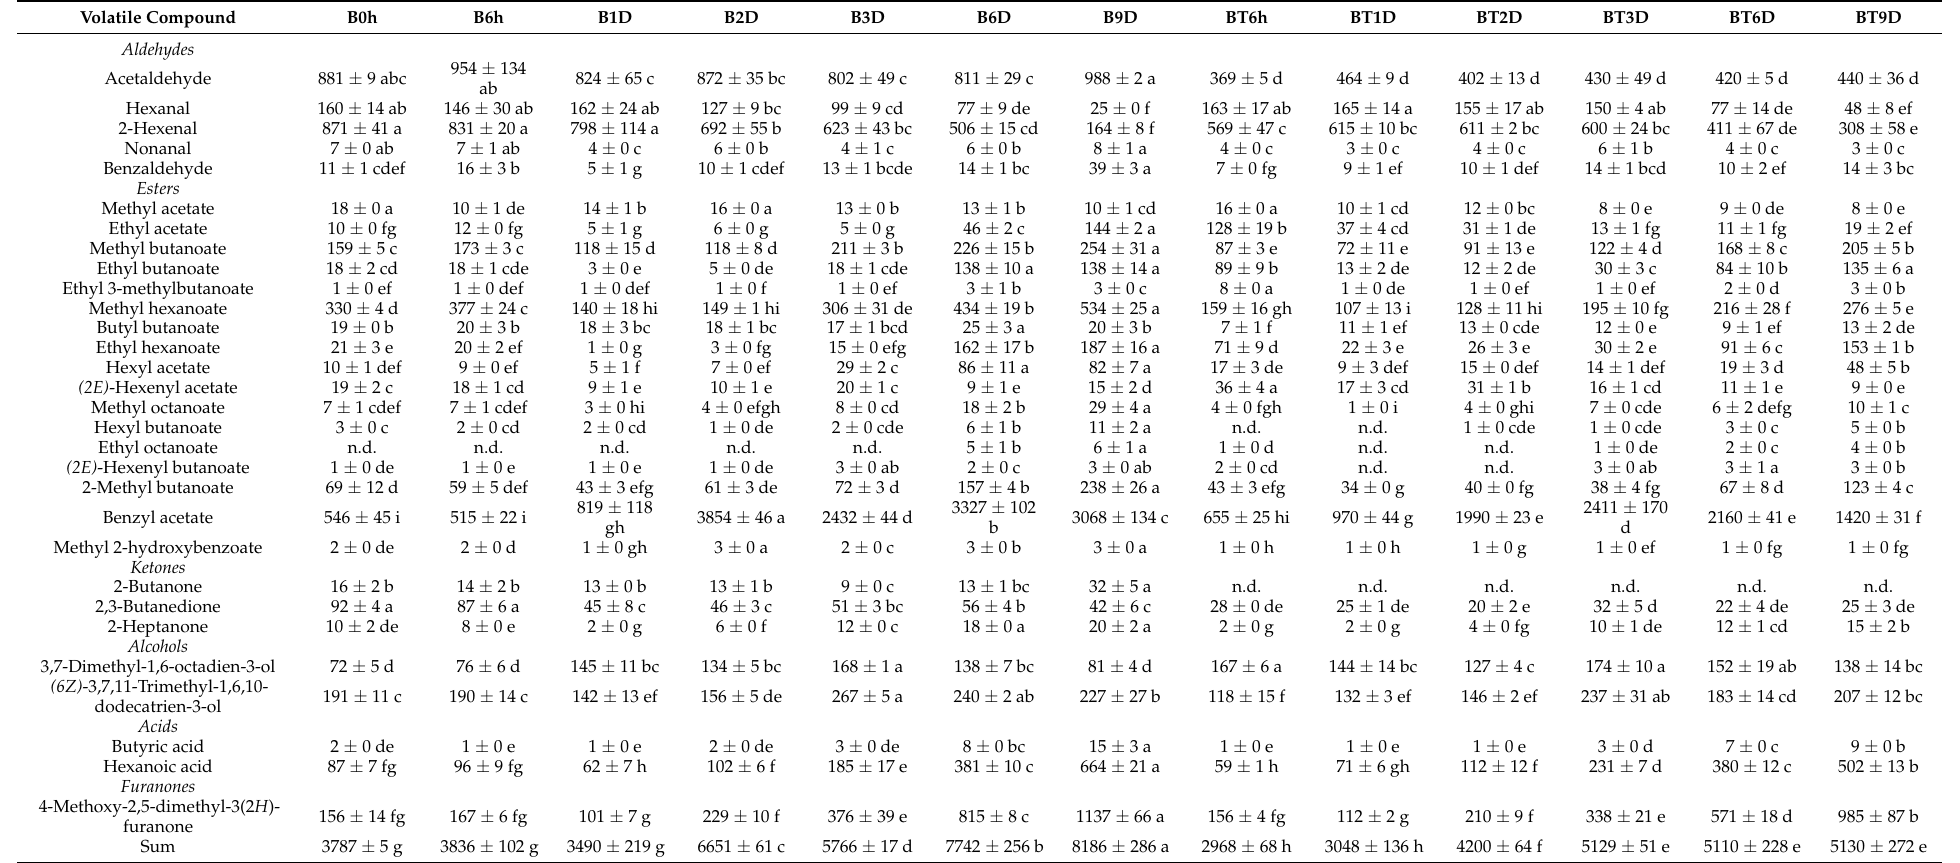
Table 3. Changes in the relative concentrations of volatile compounds in untreated (control) and CO 2 -treated bright-red